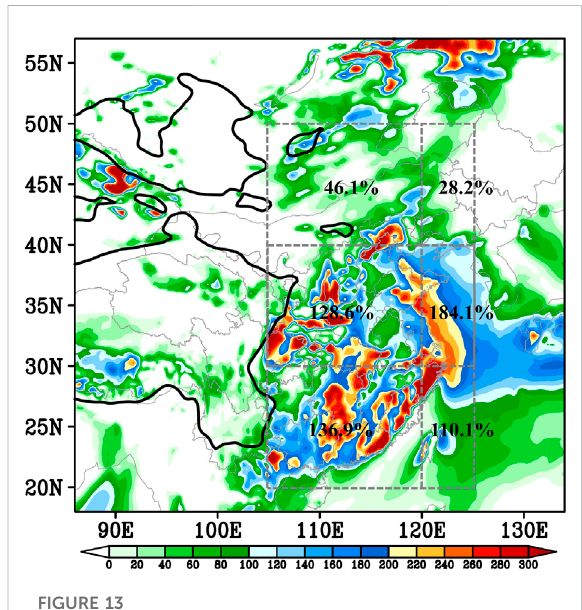
FIGURE 13 Increasing ratio (shading; %) of the temporal average of the wind power density during the cold wave event discussed in this study relativeto that during thewintersof2016 – 2020. Thick black line=terrainat1,500 m.Graydashedboxes=sixcomparison areas (I – VI; Figure 12D). Numbers = region-averaged increasing ratios,